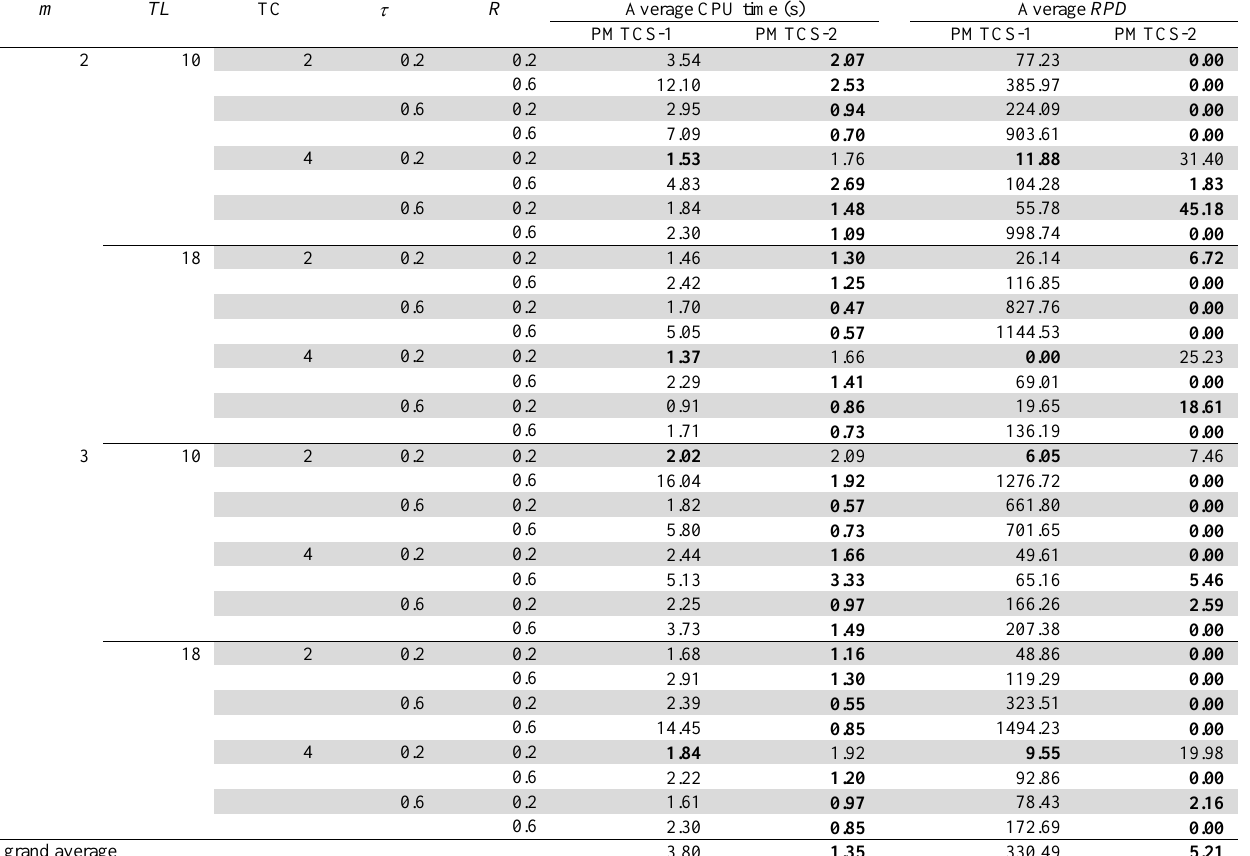
Computational results for problems with 8